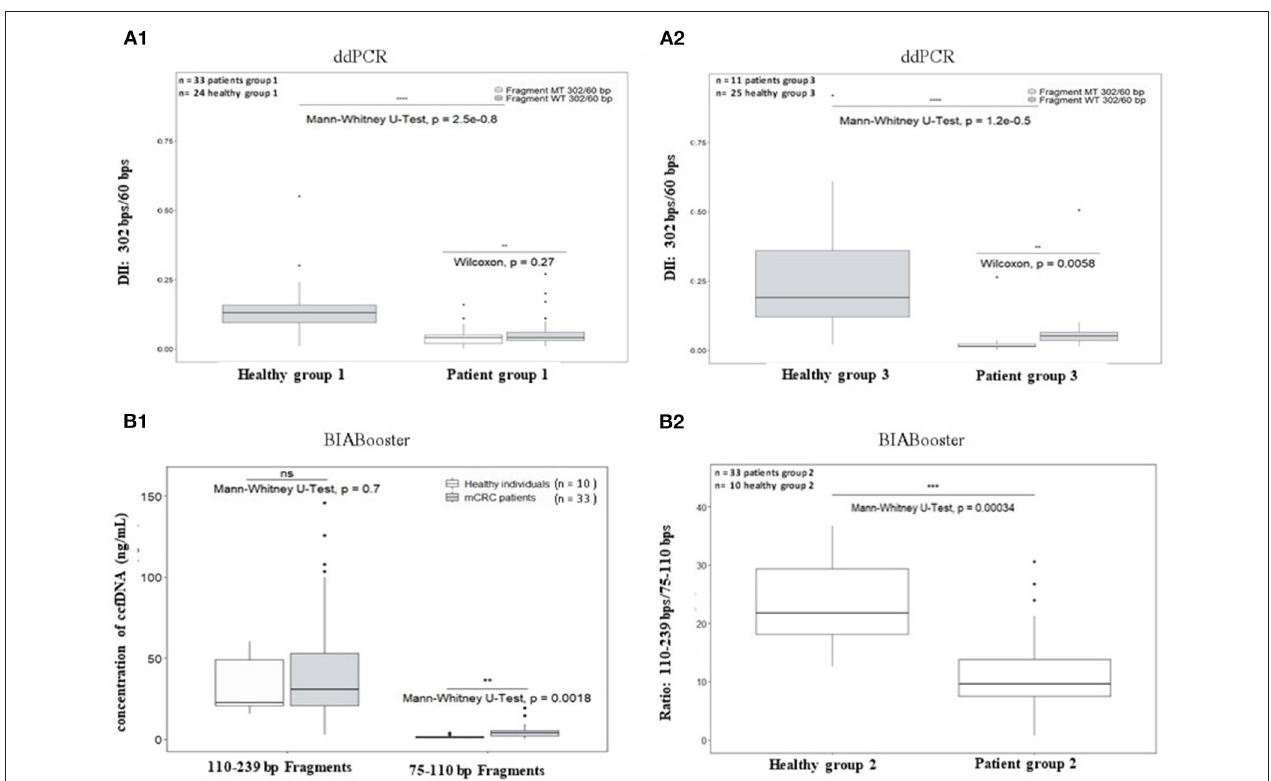
FIGURE 5 | Comparison of plasma ccfDNA integrity and ccfDNA size profiling between healthy individuals and metastatic CRC patients. As ccfDNA from different patients’ groups were prepared with different preanalytic conditions (blood collection tubes and ccfDNA extraction kits), DII comparative analysis was performed for each patient group samples using healthy subject samples collected and treated with the same procedure (see workflow Figure 2 ). To calculate DII by ddPCR, 302 bp amplicon was used as long fragment and 60 bp amplicon as short fragment ( A1 : AGEO RASANC cohort and A2 : PLACOL cohort). Two samples (one from AGEO RASANC study and one from PLACOL study) have been excluded due to an absence of detection of droplets bearing DNA-mutated fragments of 302 bp or more. To investigate different size distributions by the BIAbooster System, fragments with size ranging from 110 to 239 bp were used as long fragments and fragments with size ranging from 75 to 110 bp as short fragments ( B1 , B2 : AGEO RASANC cohort only). Mann–Whitney U -test was used for significance analysis. * p < 0.05; ** p < 0.01; *** p < 0.001; *** p < 0.0005. Fragmentation of KRAS WT and MT alleles within ccfDNA for mCRC patients is shown in ( A1 , A2 ). Mutant-allele frequency determined with the DII assay was compared with the one determined previously using other assays for the RASANC samples [BPER NGS, Bachet et al. Ann Oncol. (25)] and PLACOL samples [ddPCR targeting 86 bp amplicon, Garlan et al. CCR. (26)]. Linear regression model is given in Supplementary Figure 6